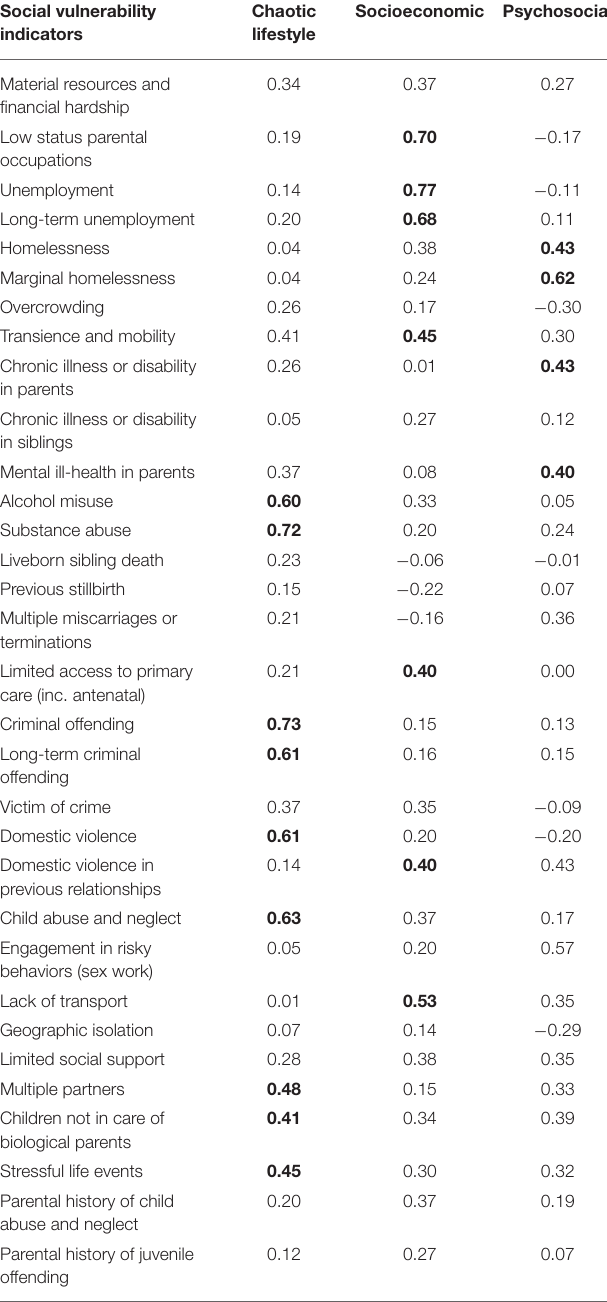
TABLE 3 | Vulnerability types created through exploratory factor analysis of the simple summation scores. Social vulnerability